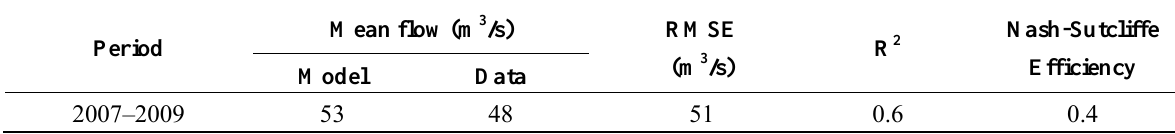
Table 4. Statistical parameters for the comparison of SWAT model predictions and field data from a hydrometric station located at